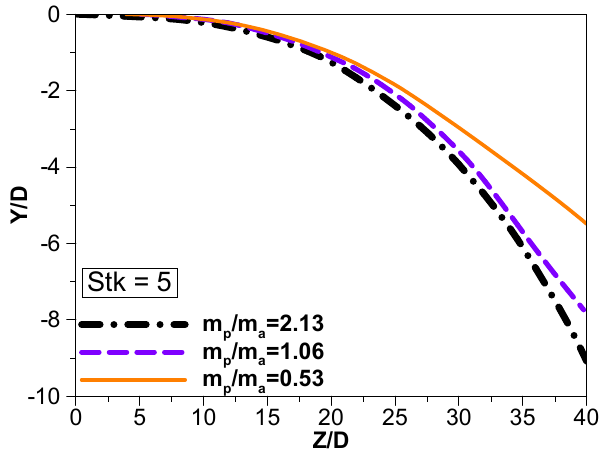
Figure 4. The effect of mass loading ratio on the trajectory of the gas-phase jet at Re = 5000.